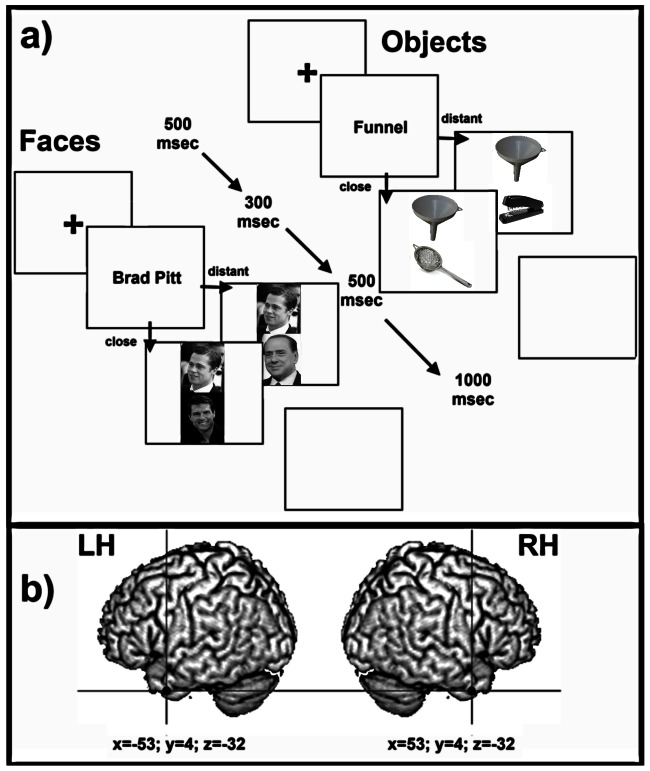
Event Sequence.panel a) event sequence and timing for both experimental conditions (Objects and Faces); panel b) anatomical coordinates of the stimulation sites for both rTMS conditions. The experimental face and object stimuli are replaced in the picture with similar stimuli obtained through an Open Access source: http://commons.wikimedia.org and are usable under CCAL. Licence permissions for each of the pictures can be found at the following links: Brad Pitt picture: adapted from http://commons.wikimedia.org/wiki/File:Angelina_Jolie_Brad_Pitt_Cannes.jpg. Attribution: Georges Biard [CC-BY-SA-3.0 (http://creativecommons.org/licenses/by-sa/3.0)], via Wikimedia Commons. Tom Cruise picture: adapted from http://commons.wikimedia.org/wiki/File:TomCruiseDec08MTV_cropped.jpg. Attribution: MTV Live [CC-BY-SA-2.0 (http://creativecommons.org/licenses/by-sa/2.0), GFDL (http://www.gnu.org/copyleft/fdl.html) or CC-BY-SA-3.0 (http://creativecommons.org/licenses/by-sa/3.0/)], via Wikimedia Commons. Silvio Berlusconi picture: adapted from http://commons.wikimedia.org/wiki/File:Silvio_Berlusconi_%282010%29-modif.png Attribution: Public domain: By www.la-moncloa.es Derivate work: Habib M′henni (Transparency) (www.la-moncloa.es) [Public domain], via Wikimedia Commons. Funnel picture: adapted from http://commons.wikimedia.org/wiki/File:Kitchen_Funnel.jpg. Attribution: By Donovan Govan. [GFDL (http://www.gnu.org/copyleft/fdl.html) or CC-BY-SA-3.0 (http://creativecommons.org/licenses/by-sa/3.0/)], via Wikimedia Commons. Strainer picture: adapted from http://commons.wikimedia.org/wiki/File:Kitchen-Strainer.jpg. Attribution: Public domain: By Evan-Amos (Own work) [Public domain], via Wikimedia Commons. Stapler picture: adapted from http://commons.wikimedia.org/wiki/File:Black_Stapler.jpg. Attribution: By ZooFari (Own work) [CC-BY-SA-3.0 (http://creativecommons.org/licenses/by-sa/3.0)], via Wikimedia Commons.